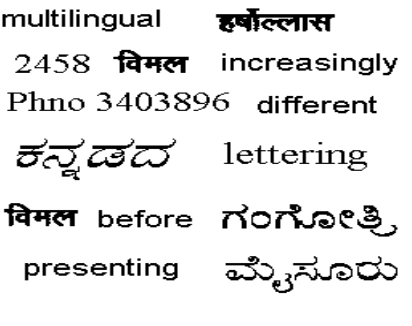
Figure 6. Sample input document containing Kannada, Hindi, English text words and Hindu Arabic